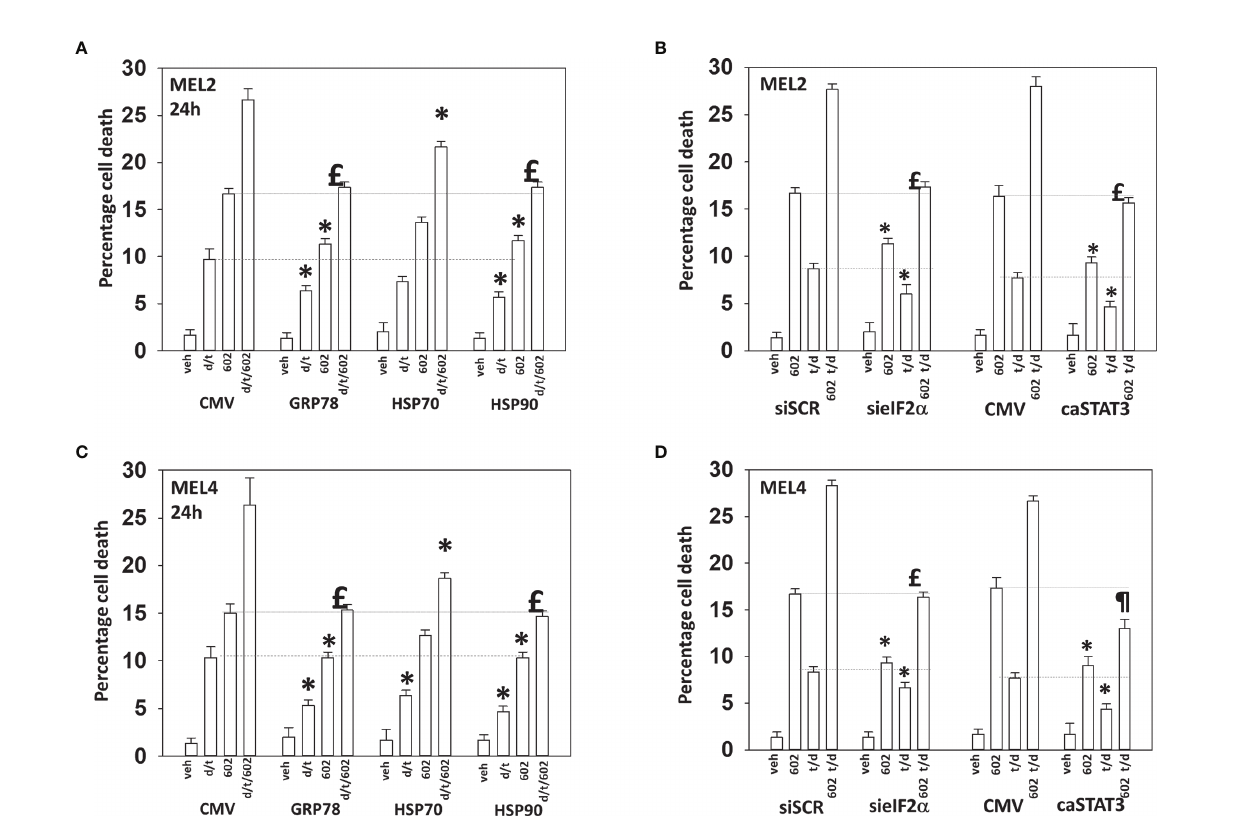
FIGURE 9 | Over-expression of GRP78 or HSP90, to a greater extent than HSP70, reduces drug lethality in melanoma cells. (A) and (B) Melanoma cells were transfected with an empty vector plasmid (CMV) or with plasmids to express the chaperones GRP78, HSP70 or HSP90. Twenty-four h later, cells were treated with vehicle control, GZ17-6.02 [curcumin (2 µM) + isovanillin (37.2 µM) + harmine (4.5 µM)], [trametinib (t, 2 µM) + dabrafenib (d, 2 µM)] or the drugs in combination for 24h. Cells were isolated and viability determined by trypan blue exclusion (n = 3 +/- SD). *p < 0.05 less than corresponding value in CMV transfected cells; £ p > 0.05 comparing d/t/602 value to 602 alone value in CMV cells. (C) and (D) Cells were transfected with a scrambled siRNA or with a validated siRNA molecule to knock down the expression of eIF2 a . Cells were transfected with an empty vector plasmid (CMV) or with a plasmid to express activated STAT3. Twenty-four h later, cells were treated with vehicle control, GZ17-6.02 [curcumin (2 µM) + isovanillin (37.2 µM) + harmine (4.5 µM)], [trametinib (t, 2 µM) + dabrafenib (d, 2 µM)] or the drugs in combination for 24h. Cells were isolated and viability determined by trypan blue exclusion (n = 3 +/- SD). *p < 0.05 less than corresponding value in transfected cells; £ p > 0.05 comparing d/t/602 value to 602 alone value in their corresponding transfected cells; ¶ p < 0.05 less than 602 single agent value in CMV transfected